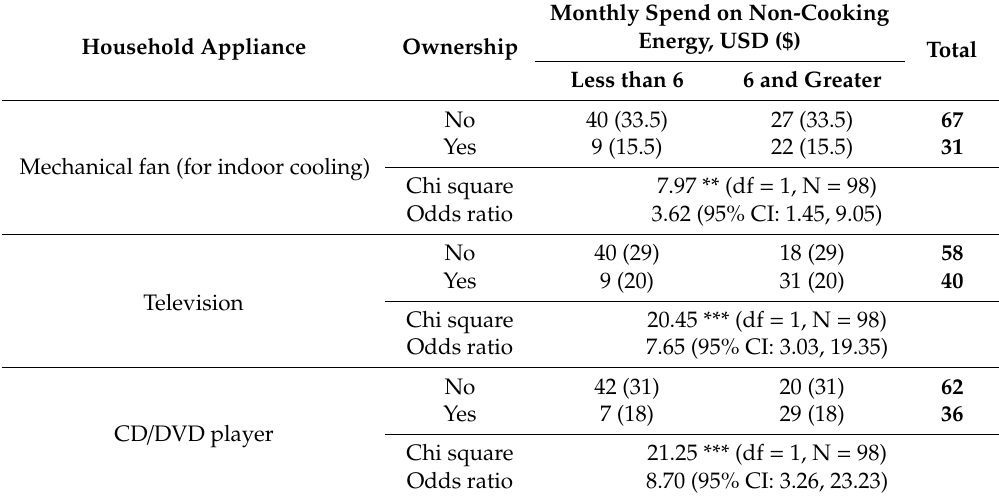
Table 5. Association between the ownership of household appliances and the monthly spend on non-cooking household energy,